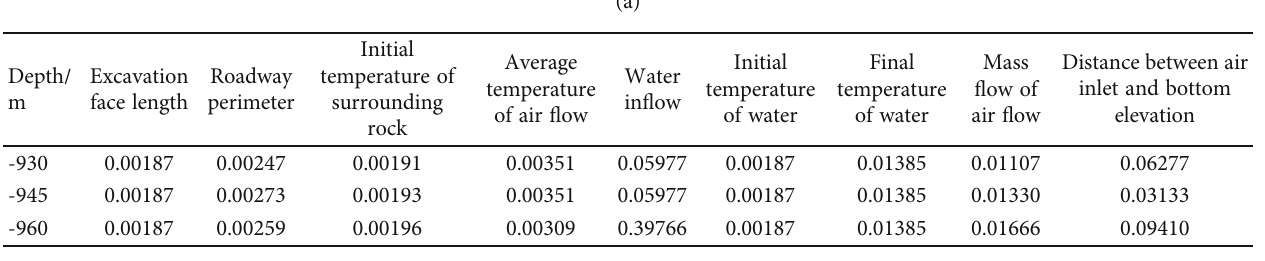
Table 8: Weighted standardized decision matrix for each indicator. (a)